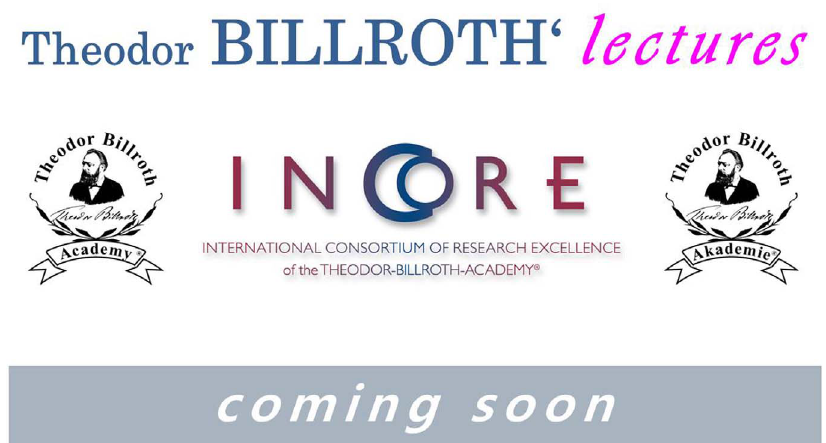
Figure 5. Theodor BILLROTH ’ s lectures, which will be cost-free for students and residents and which will arrive